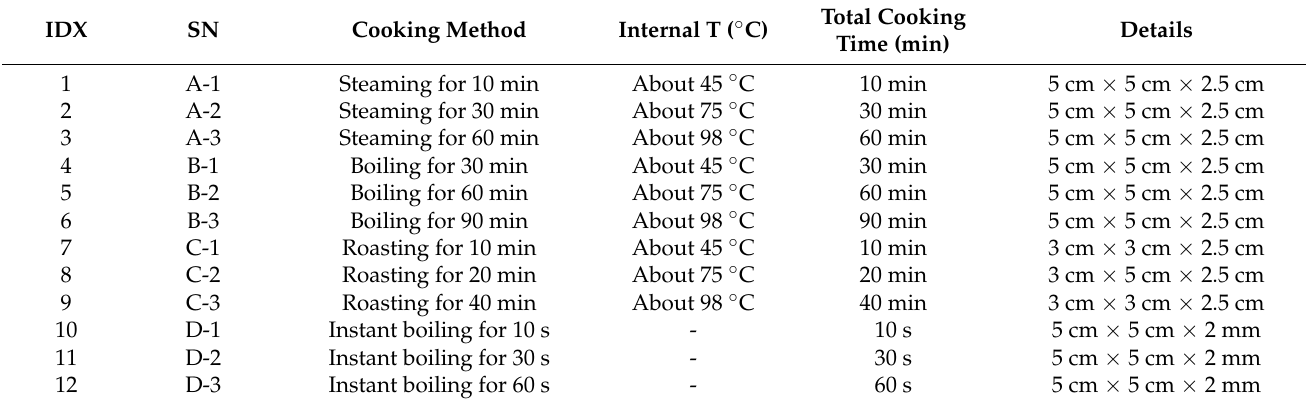
Table 1. Information on the Pingliang red beef samples and their cooking methods.